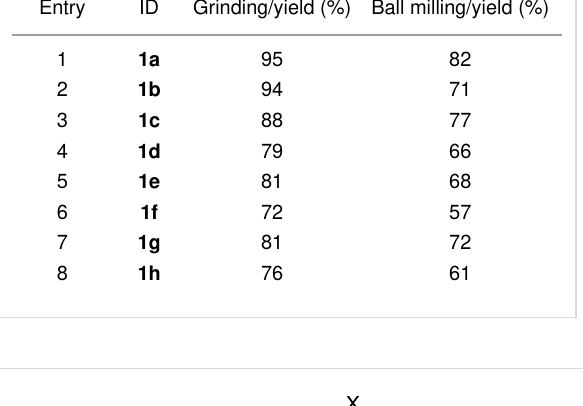
Table 1: Yields of unsymmetrical salens 1 using grinding and ball milling. Entry ID Grinding/yield (%) Ball milling/yield